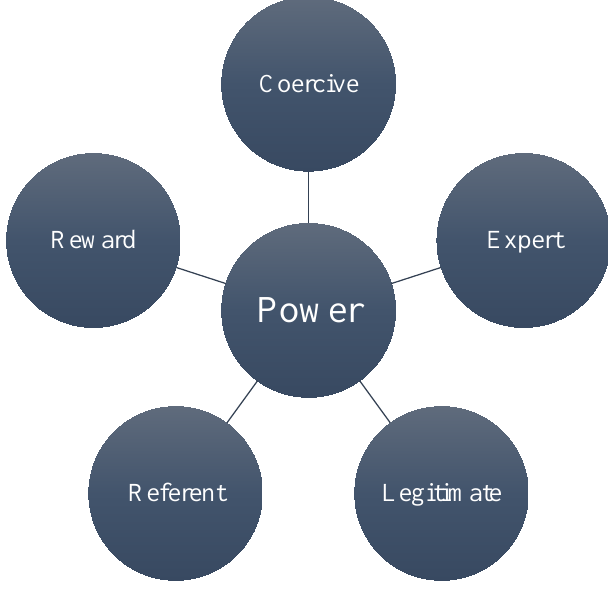
Fig 1. Five sources of organizational